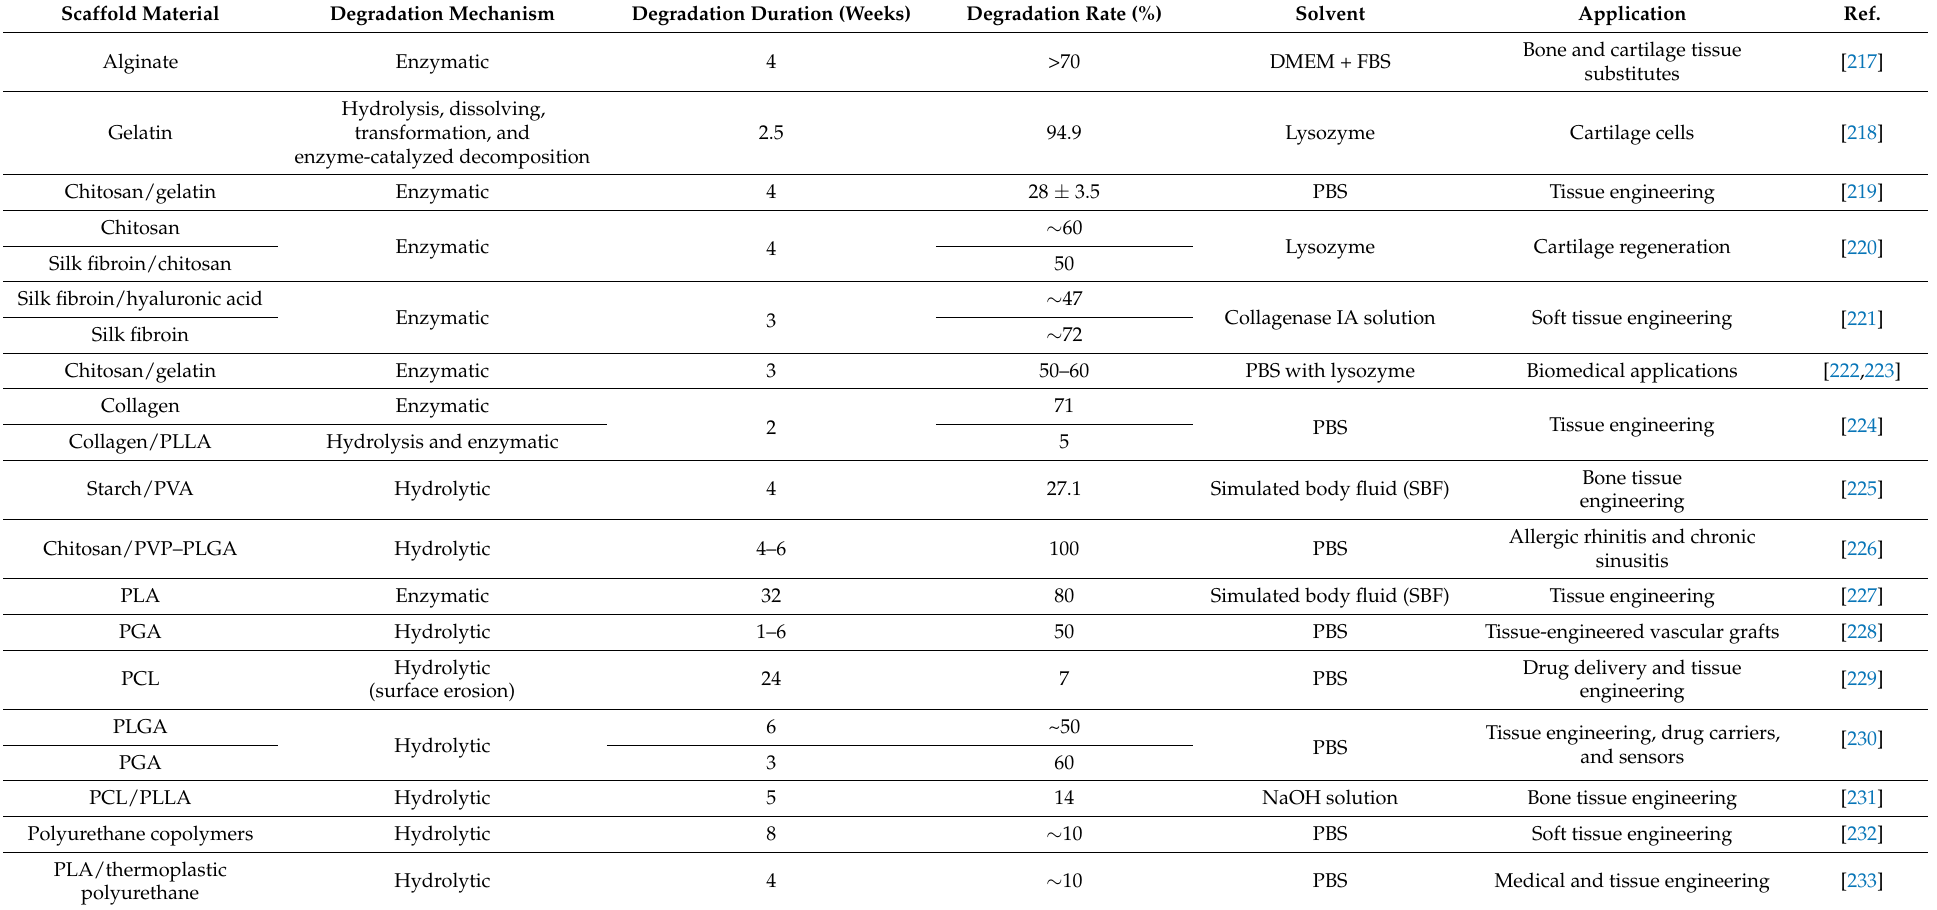
Table 4. Degradation mechanism of biodegradable polymer